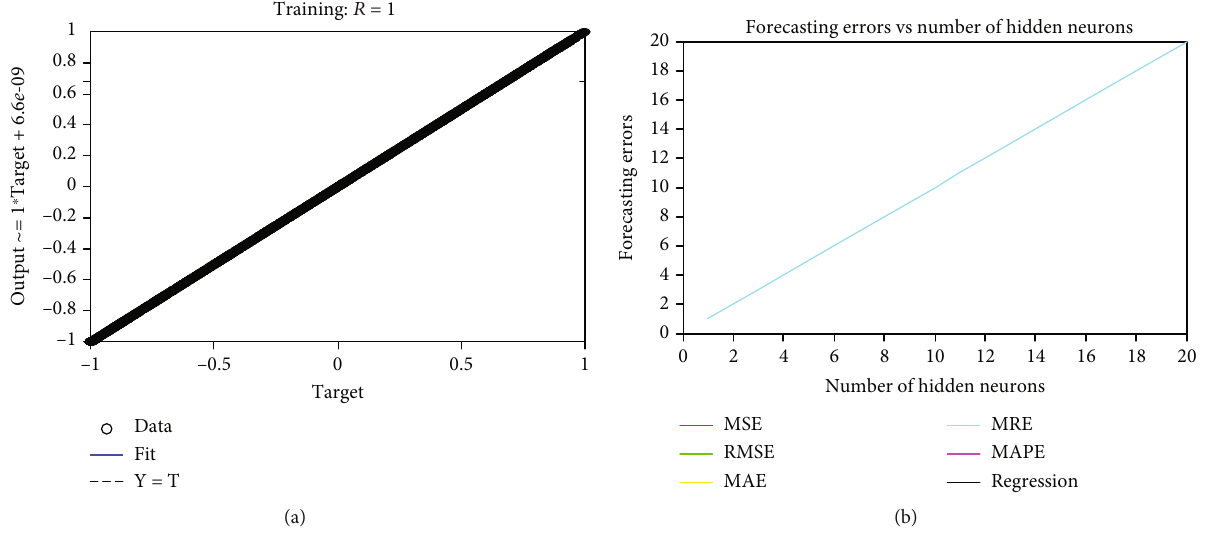
Figure 6: (a) Two input MLPNN-based forecasting model regression graphs. (b) Two input MLPNN-based forecasting model forecasting errors vs. the number of hidden